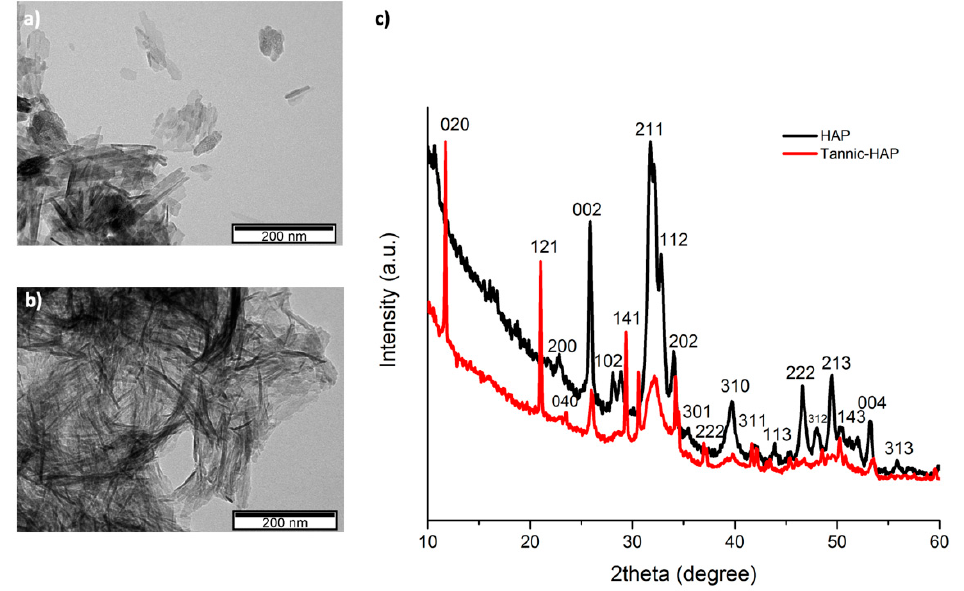
Figure 1. TEM images of ( a ) blank HAP particles, ( b ) HAP particles loaded with tannic acid, and ( c ) XRD analysis for blank and tannic acid-loaded HAP.